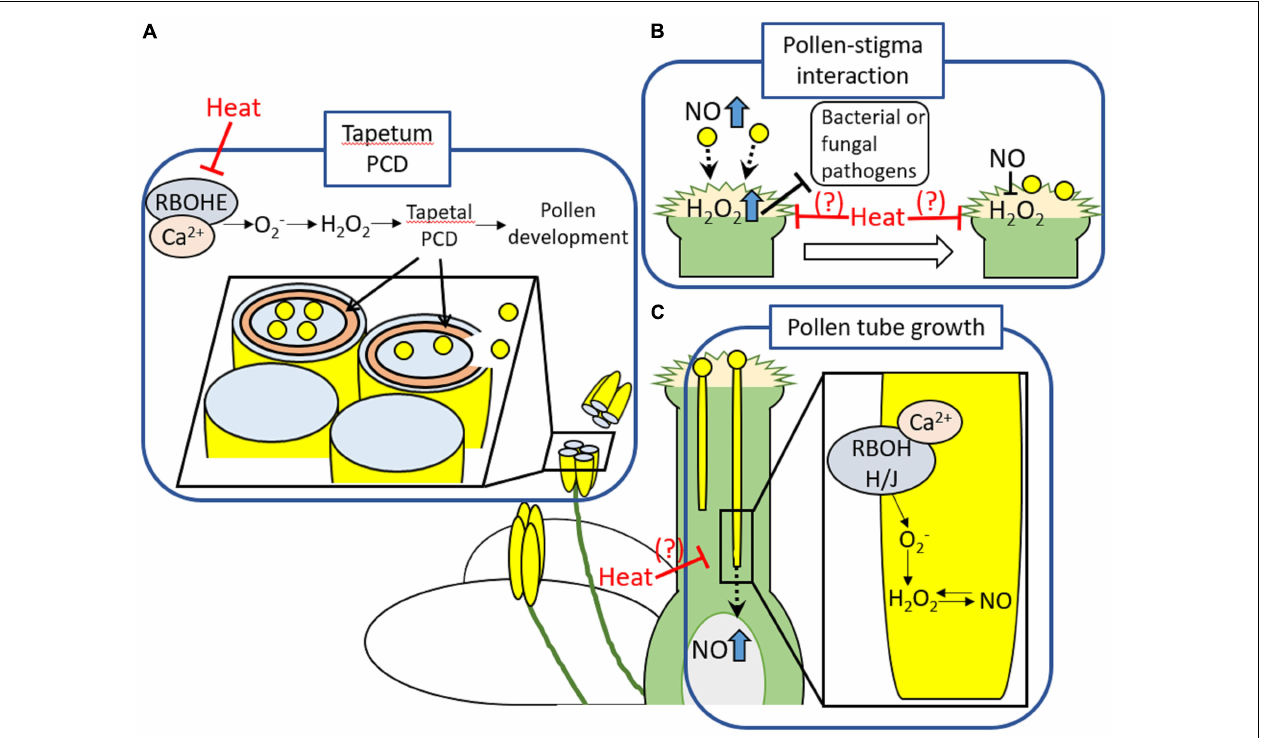
FIGURE 1 | Developmental processes in reproductive tissues involving ROS production or PCD. (A) RBOHE that might be activated by Ca 2 + produces ROS to enhance tapetal PCD. This process occurred in the appropriate timing might be required for the proper development of pollens. (B) High level of NO and H 2 O 2 accumulation in pollens and papilla cells, respectively, might be essential for the recognition of pollens by papilla cells followed by the attachment of pollens to the top of stigma. In addition, level of H 2 O 2 could be sufficient to protect papilla cells against pathogens, but, not as much as causing damage (Hiscock and Allen, 2008). Following the attachment of pollen on the stigma, NO derived from pollen might function to decrease the level of H 2 O 2 accumulation in stigma. The same tendency in ROS and NO level at the arrival of pollens to pistils was commonly observed among the different species (Zafra et al., 2010). These findings suggest that dramatic shift of the ROS-NO redox state could be required for initiation of pollen germination. However, significance of the decrease in H 2 O 2 level in papilla cells in fertilization is still not clear. (C) RBOHH and RBOHJ that might be activated by Ca 2 + produce ROS to regulate pollen tube growth. Appropriate level of RBOHH/J-dependent ROS production might be maintained by NO signals. Production of NO in ovule might be also involved in guidance of pollen tube growth (Serrano et al., 2015). These developmental processes required for fertilizations are sensitive to heat stress. Indeed, tapetal PCD was shown to be inhibited by heat stress (De Storme and Geelen, 2014). Effects of heat stress on ROS signaling involved in other developmental processes in reproductive tissues should be elucidated in more